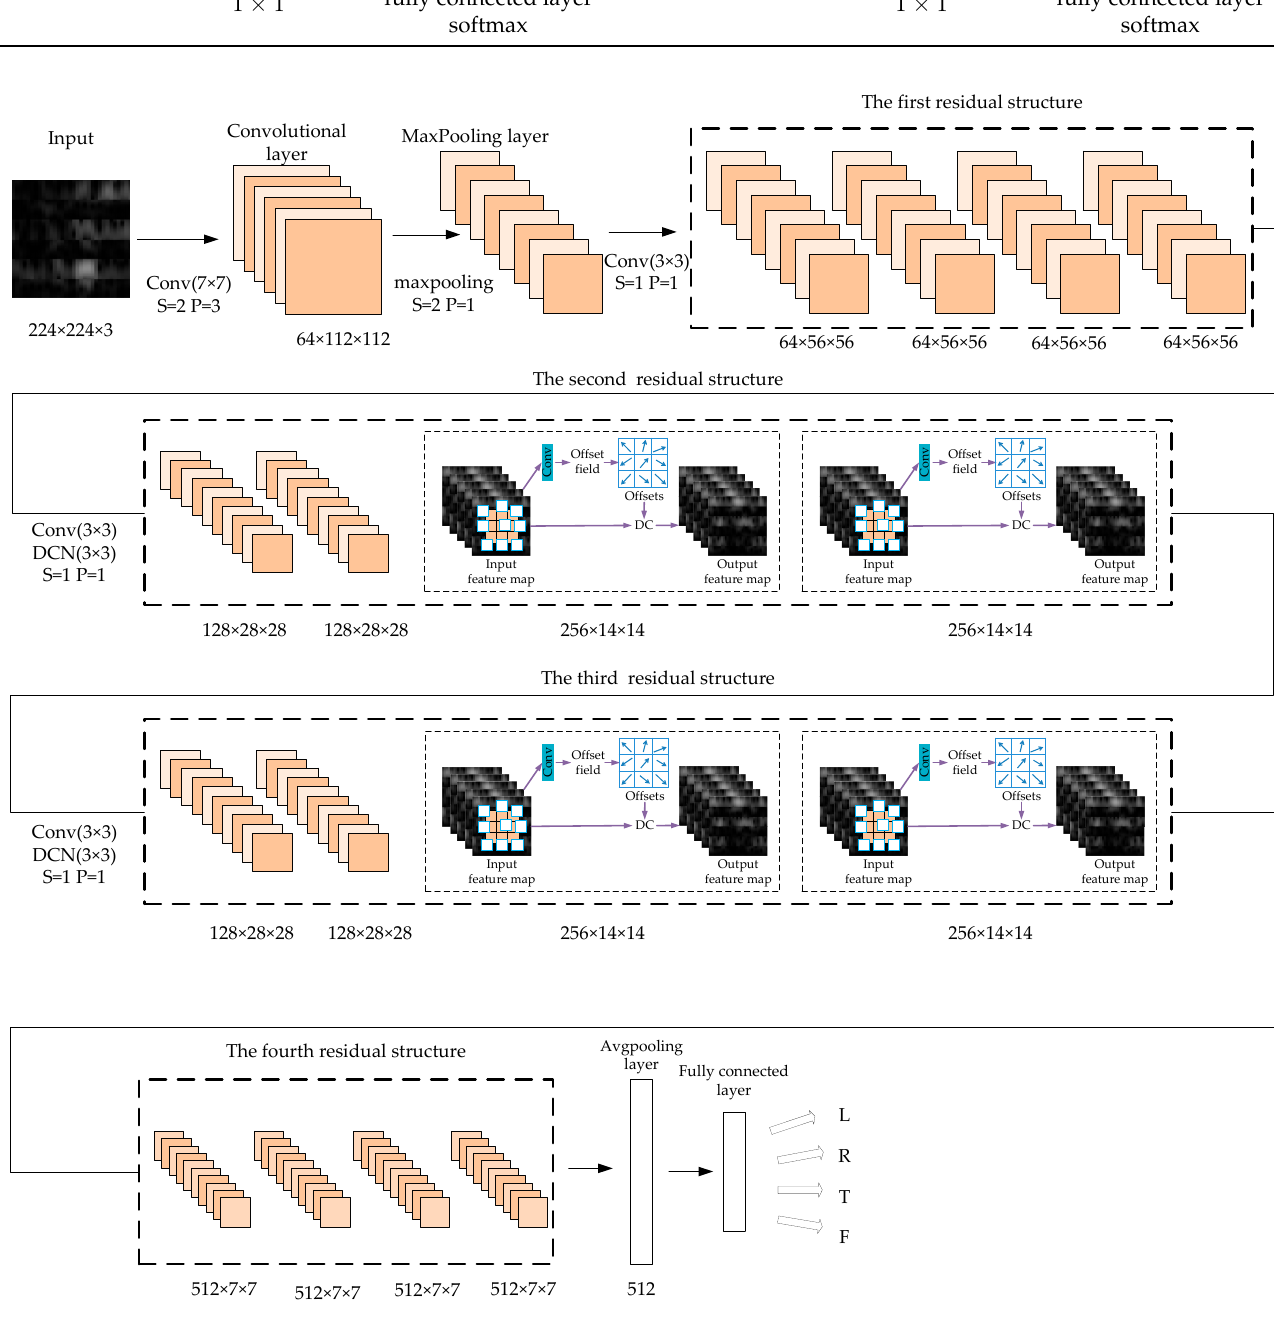
Figure 6. DCN-ResNet18 neural network structure. Based on the above, the block diagram of the developed motor imaging EEG signal recognition is depicted in Figure 7.